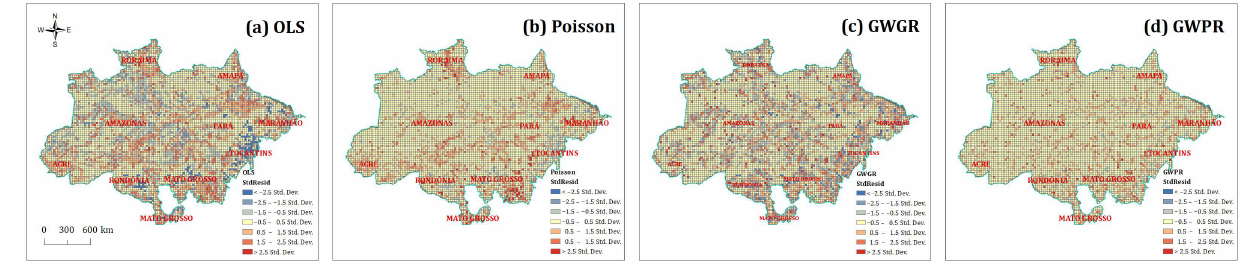
Figure 8. The standardized residuals from ( a ) OLS, ( b ) Poisson, ( c ) GWGR, and ( d )